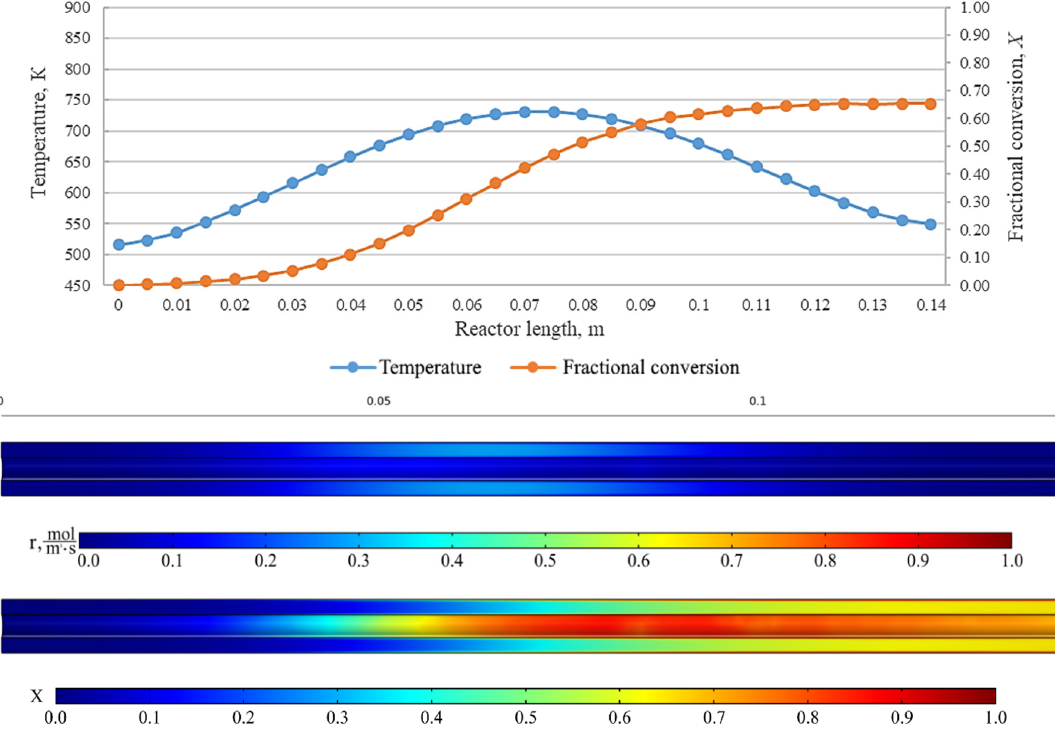
Figure 18. From top to bottom: temperature and fractional conversion curves, profiles of the reaction rate and fractional conversion along the reactor length for the experiment cyGOm_450_116 (Tmax = 450 °С , 𝑉(cid:4662) = 0.05 L/min).